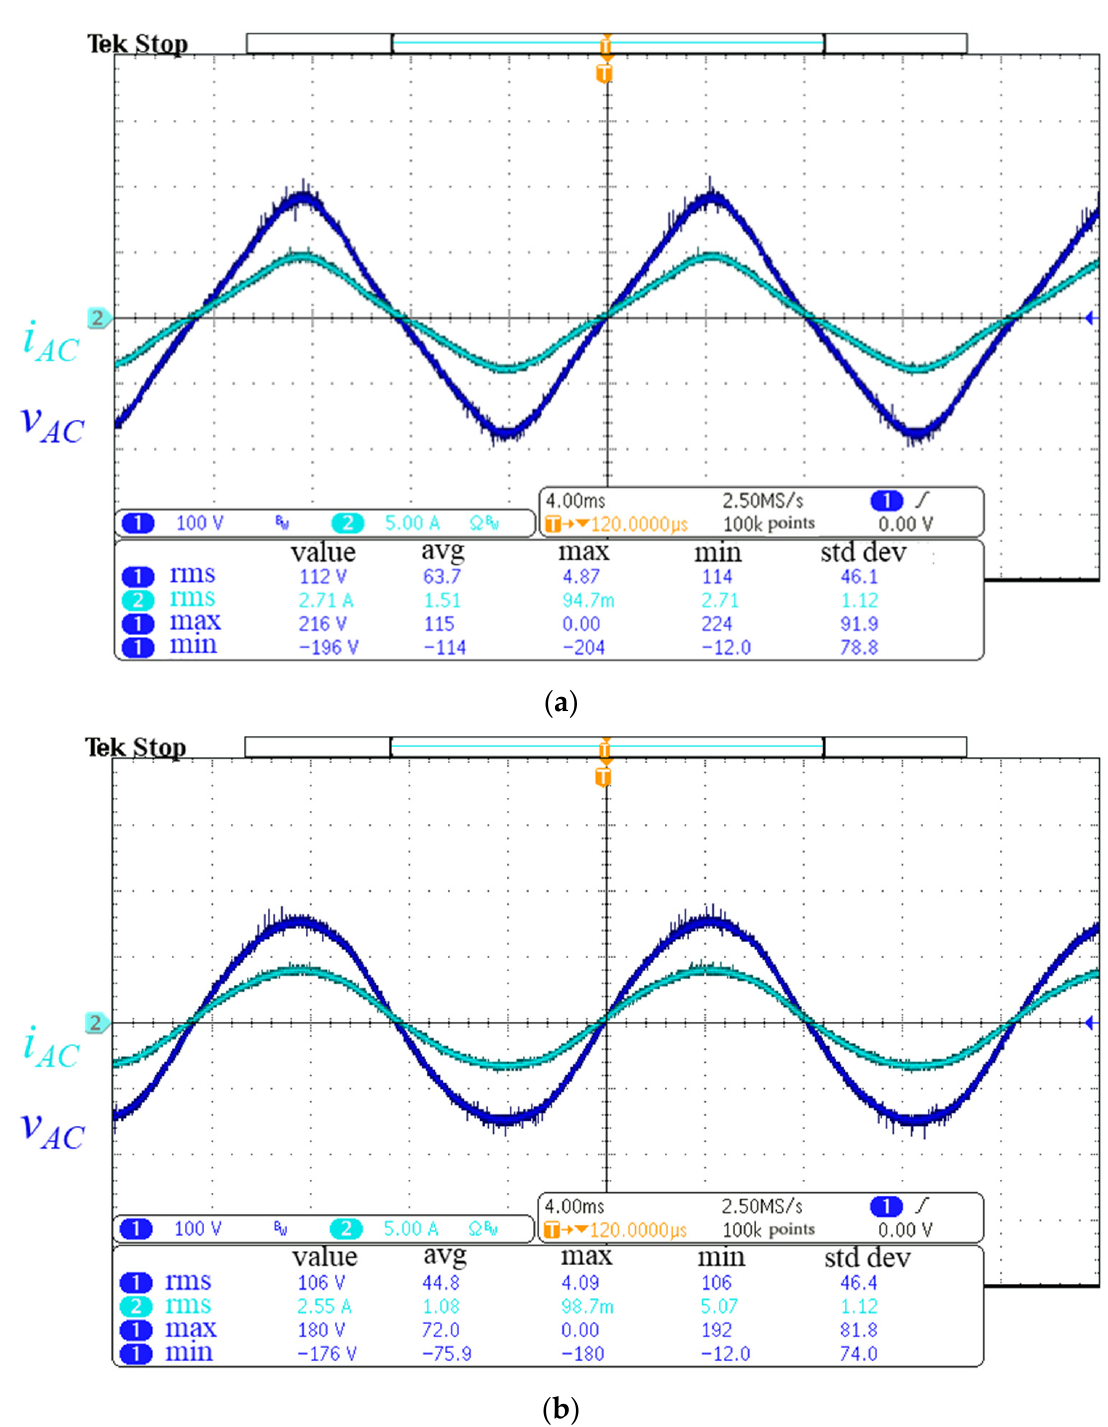
Figure 18. The measured results (250 W) of the voltage and current output waveforms when using ( a ) the traditional SPWM control and ( b ) modified SPWM control.